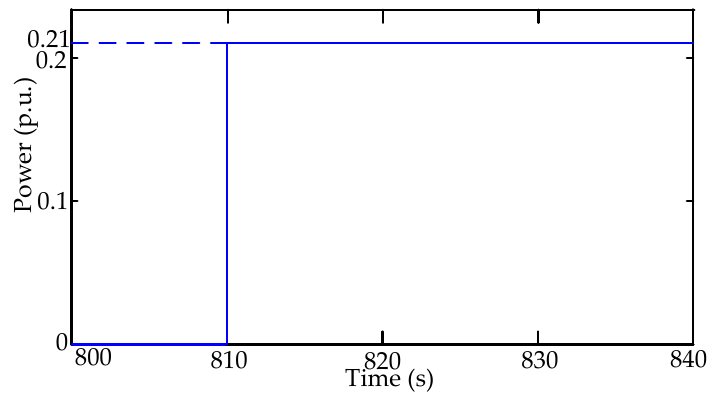
Figure A1. The disturbance input of Area 1.